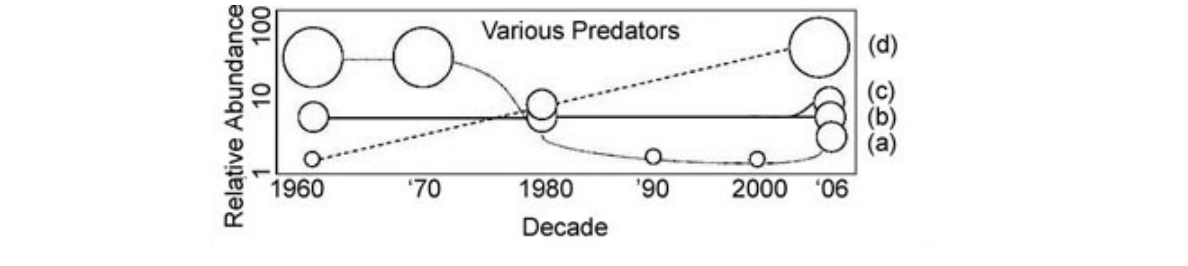
Fig. 4. Various patterns were seen across predators on the coral reefs. Four social-ecological guilds are represented on this diagram, including: (a) the “Invasives”, roi (Peacock grouper, Cephalopholis argus ) and ta‘ape (Bluestripe snapper, Lutjanus kasmira ), (b) Tiger Sharks ( Galeocerdo cuvier ), (c) Eels (Anguilliformes)/Reef Sharks ( Triaenodon obesus ), and (d) Ulua (Jack, Carangoides spp. & Caranx spp.)/Native